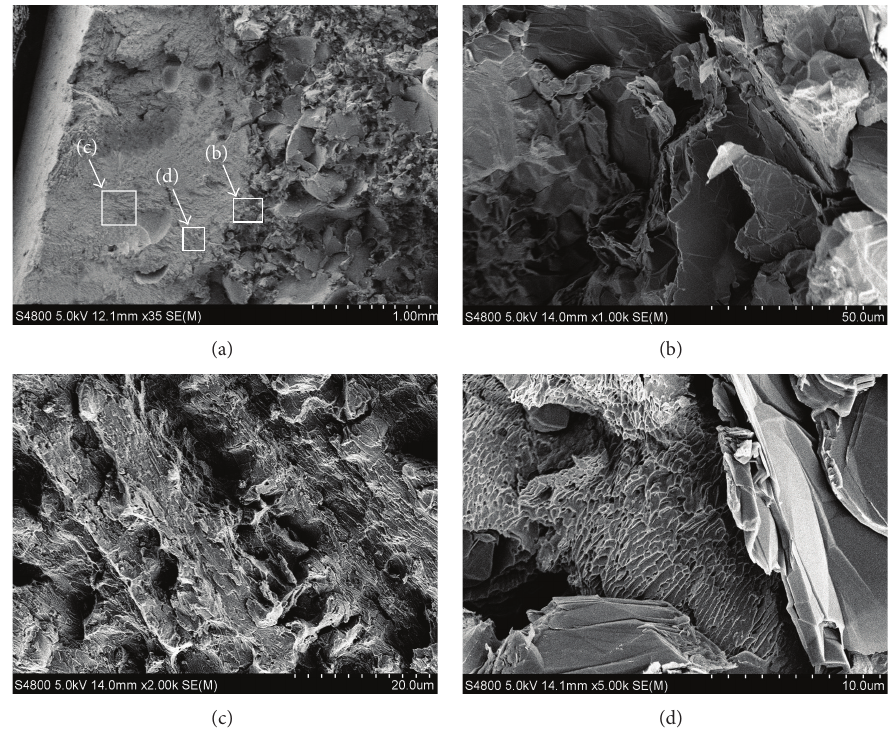
Figure 11: Fracture appearances of 316L sample: (a) marcoappearance SEM × 35, (b) BZ SEM × 1000, (c) RZ SEM × 2000, and (d) BZ SEM × 2000.